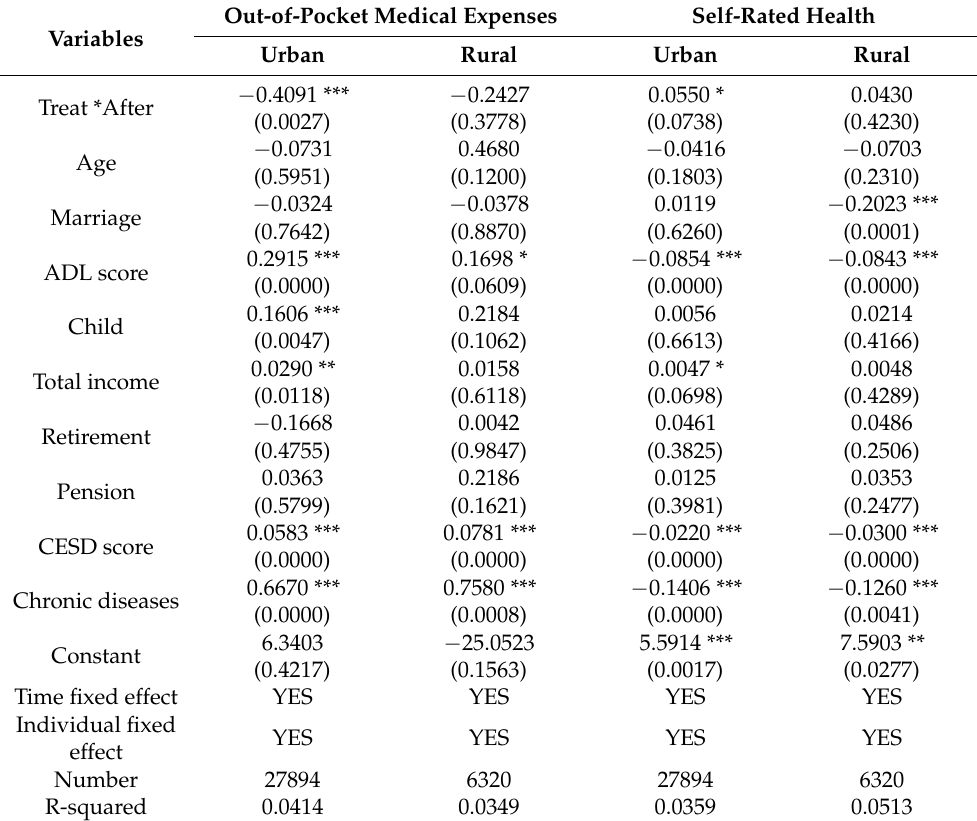
Table 8. Urban and rural heterogeneity